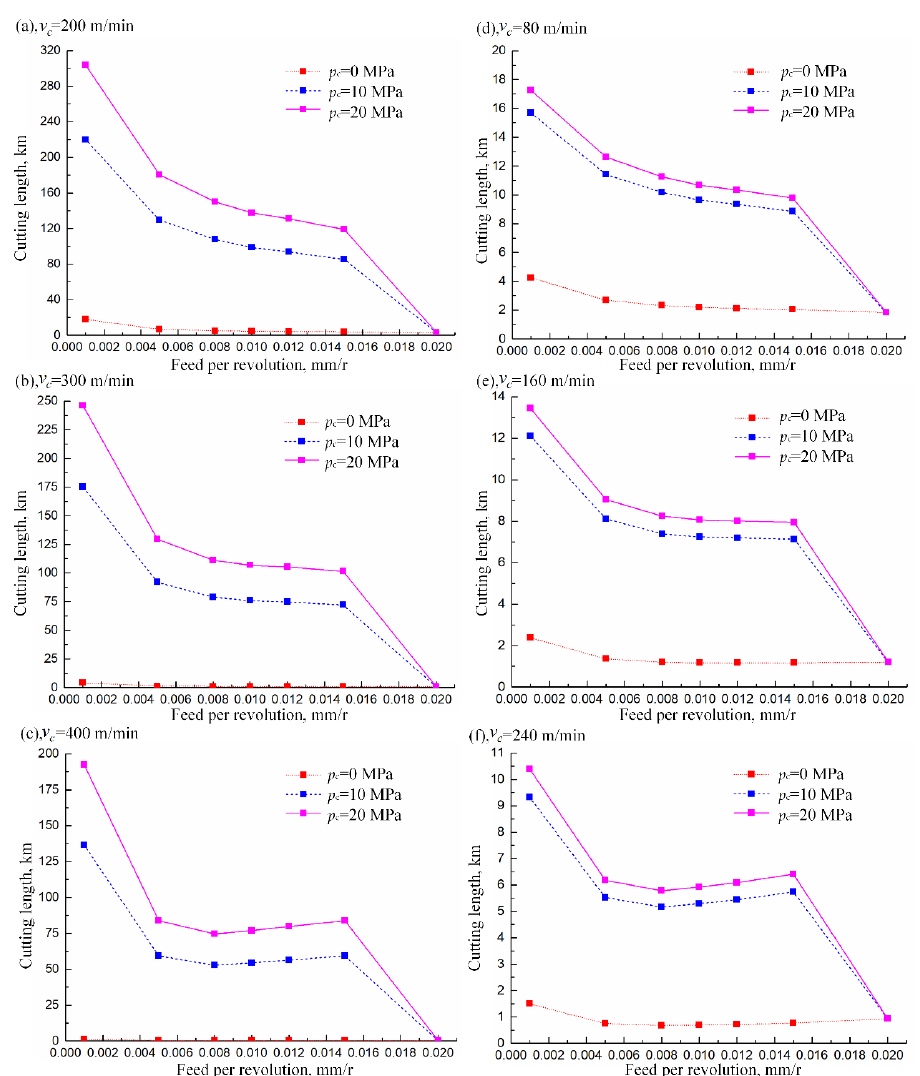
Figure 16. Tool life versus feed per revolution during HUVC of ( a – c ) Ti alloys with cutting depth 0.05 mm and ( d – f ) Ni alloys with cutting depth 0.2 mm. 𝑣 𝑐 , cutting speed, p c , cooling pressure.